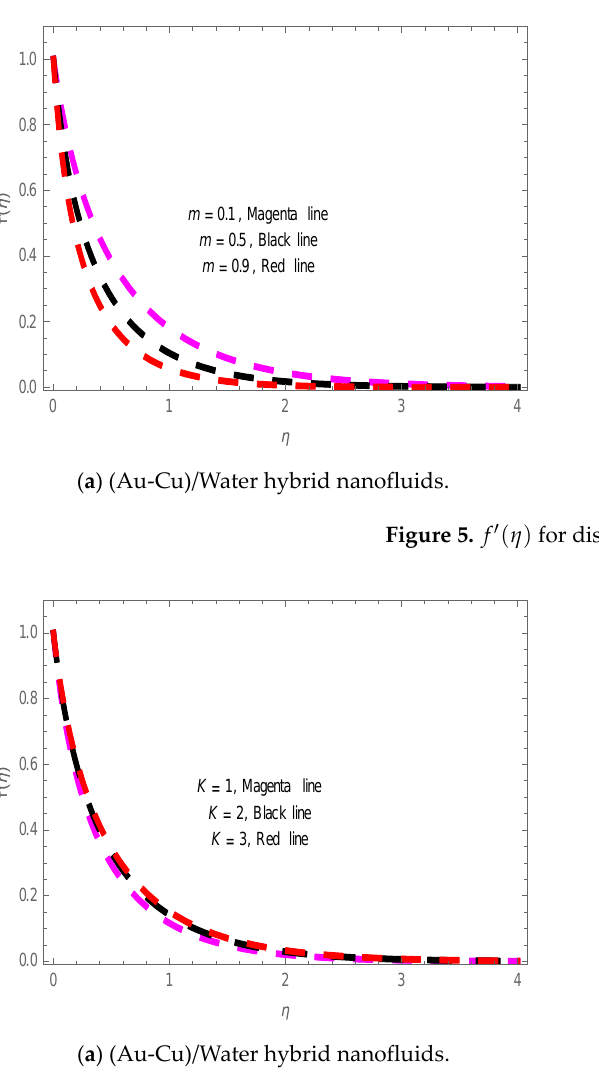
Figure 6. 𝑓 ′ (𝜂) for dissimilar values of K .